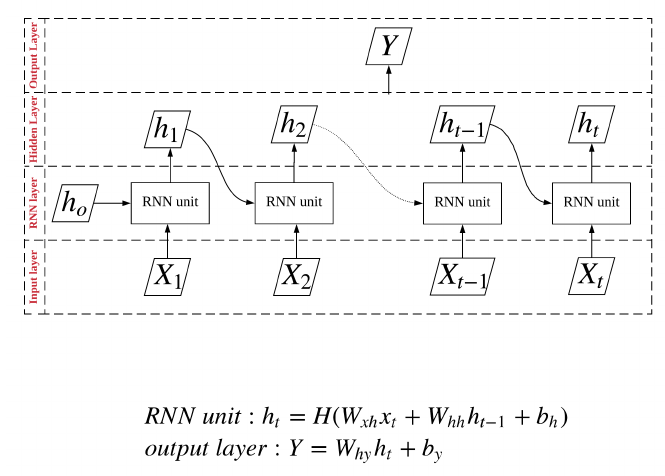
Figure 3. Structure of RNN. X t is the independent variable set at the t th epoch, and Y is the independent variable. h t is the temporary results from the t th RNN unit, h 0 is manually initialised. The connection between h and Y are normal SoftMax/regression. Each RNN unit can be considered as an ANN model (Figure 2). W s and b s are the coefficients and biases that needed to be estimated during training. In addition, H is the tanh function.